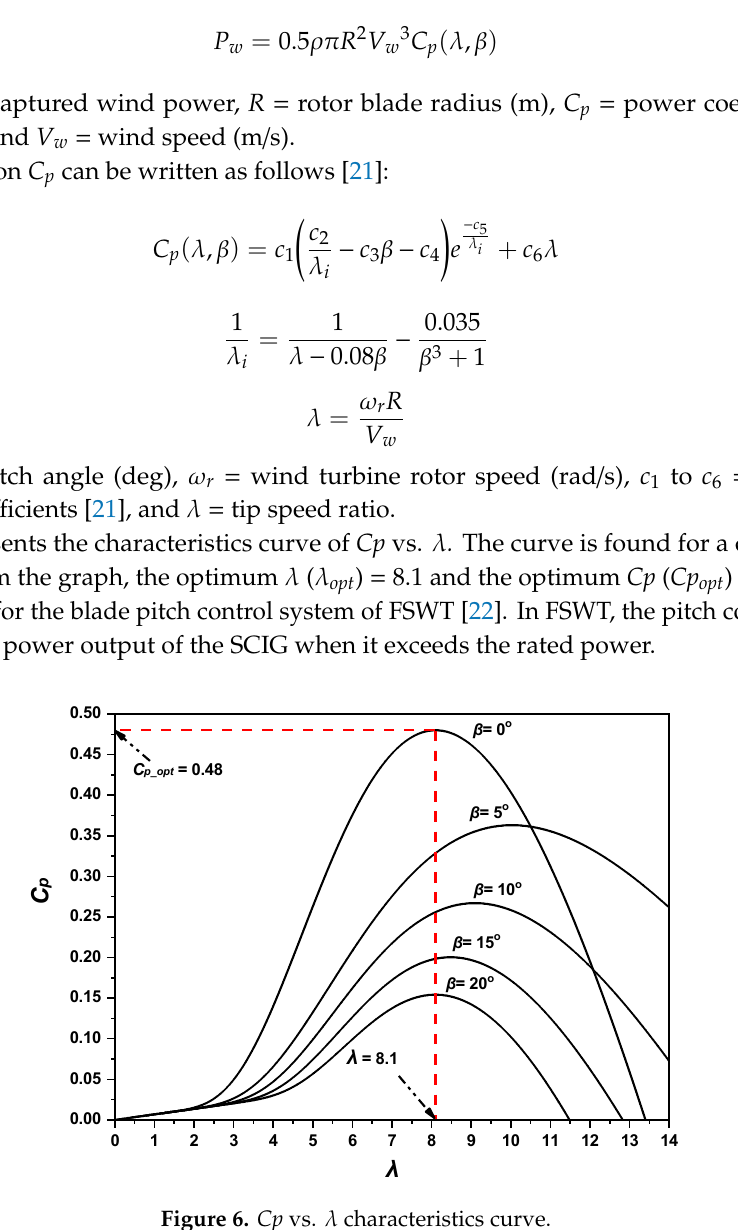
Figure 6. Cp vs. λ characteristics curve.